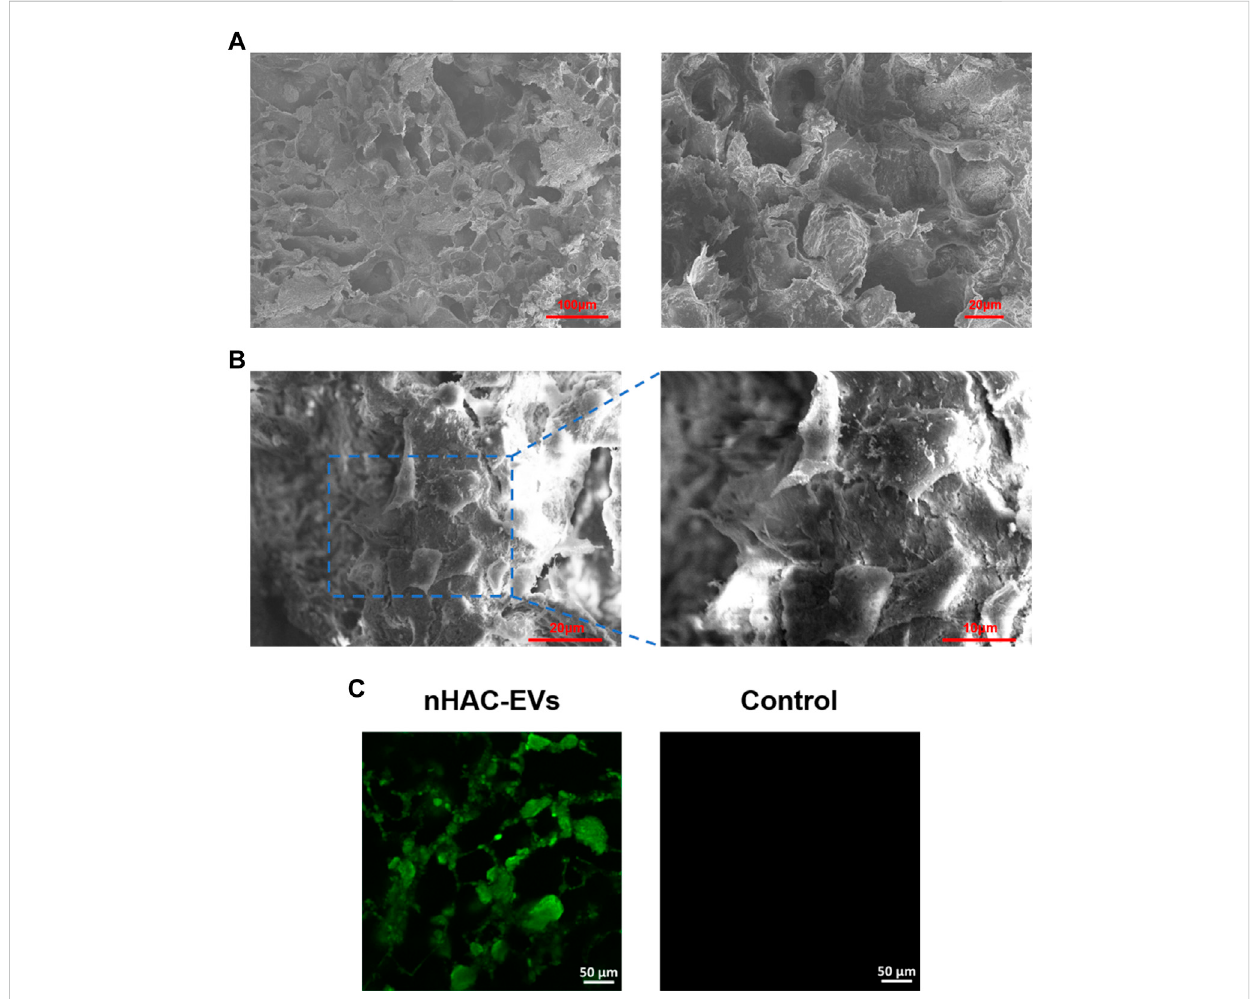
FIGURE 4 DetectionofhGMSCsandEVsonthenHACscaffold (A) SEMimageofthenHACscaffold(a:200×;b:600×) (B) SEMimageofthenHACscaffoldwith hGMSCs (a: 1100×; b: 2200×) (C) LSCM images of the nHAC scaffold with DiO-labeled